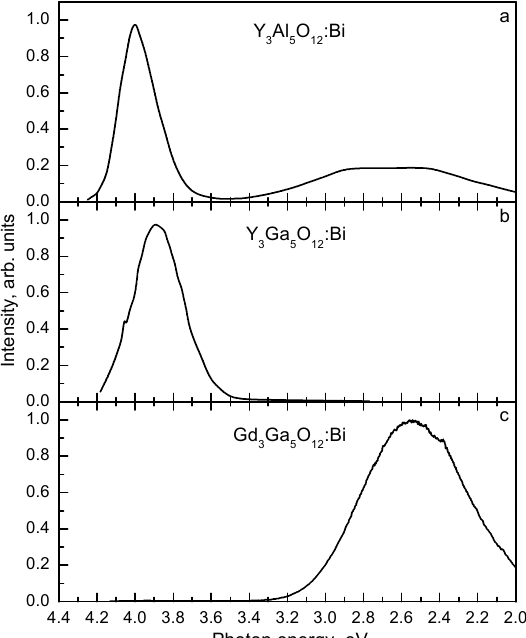
Figure 12. Emission spectra of ( a ) Y 3 Al 5 O 12 :Bi [17], ( b ) Y 3 Ga 5 O 12 :Bi [13], and ( c ) Gd 3 Ga 5 O 12 :Bi [74]. T=80 K. Based on the data reported in [13,17,74], presented with the publisher permission.